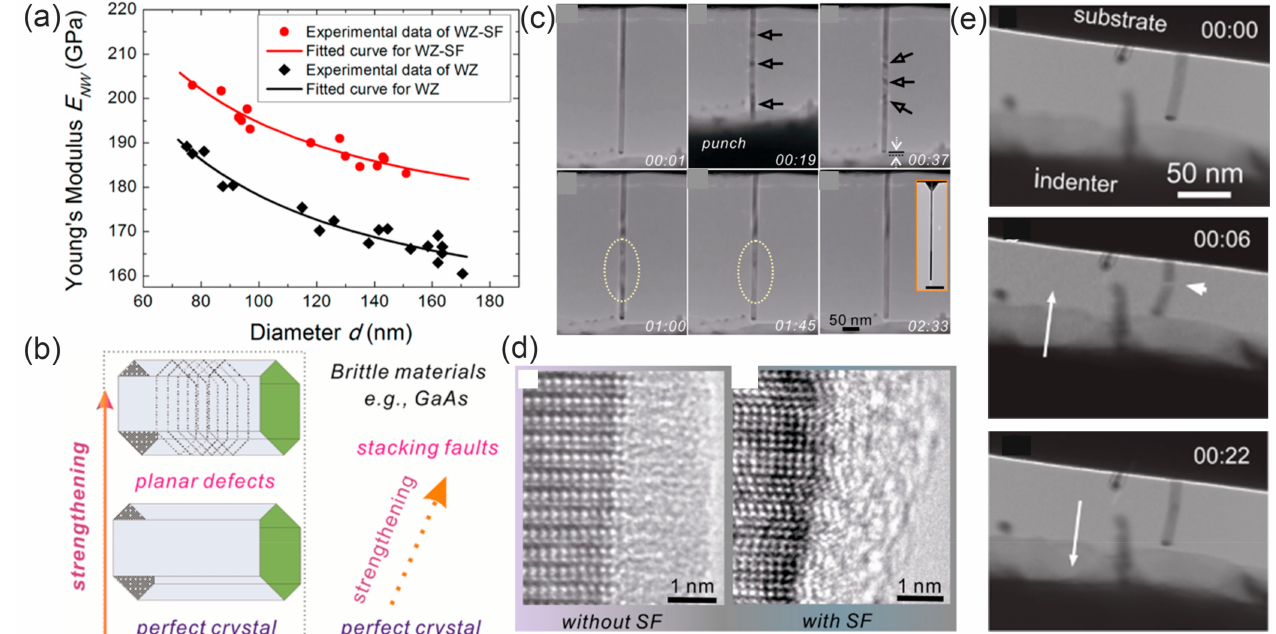
Figure 11. ( a ) The effective Young’s modulus of WZ and WZ-SF GaAs NWs as a function of diameter. Reproduced with permission [15]. Copyright 2016, American Chemical Society. ( b ) The strengthening in brittle materials through defect engineering (via the insertion of planar defects). Reproduced with permission [129]. Copyright 2013, American Chemical Society. ( c ) A series of TEM images showing the unelastic behavior of GaAs. Bending contours are marked with arrows. ( d ) Typical HRTEM images of the interface in a NW without and with stacking faults. Reproduced with permission [131]. Copyright 2013, American Chemical Society. ( e ) TEM images showing the fracture and self-healing of a GaAs NW when a compression force was applied and retracted. Reproduced with permission